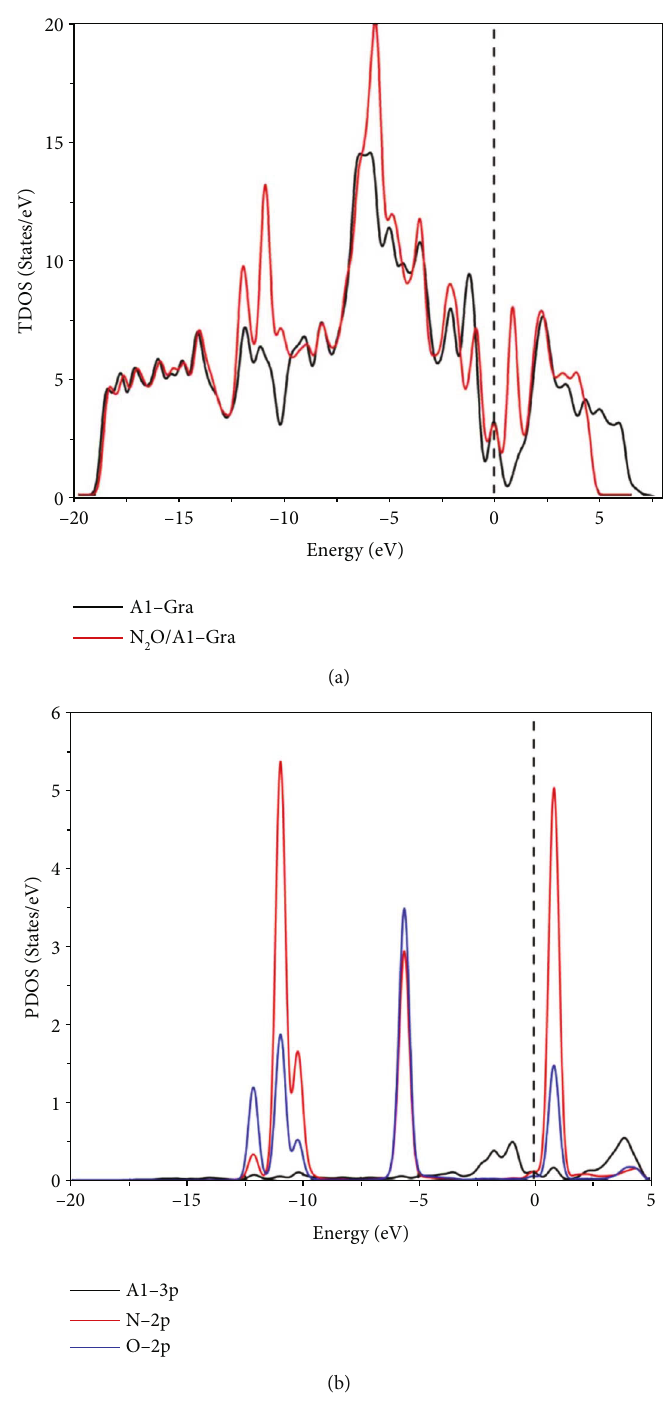
Figure 9: TDOS before and after N O adsorption and PDOS of the main interacting atoms ((a) TDOS; (b) 2